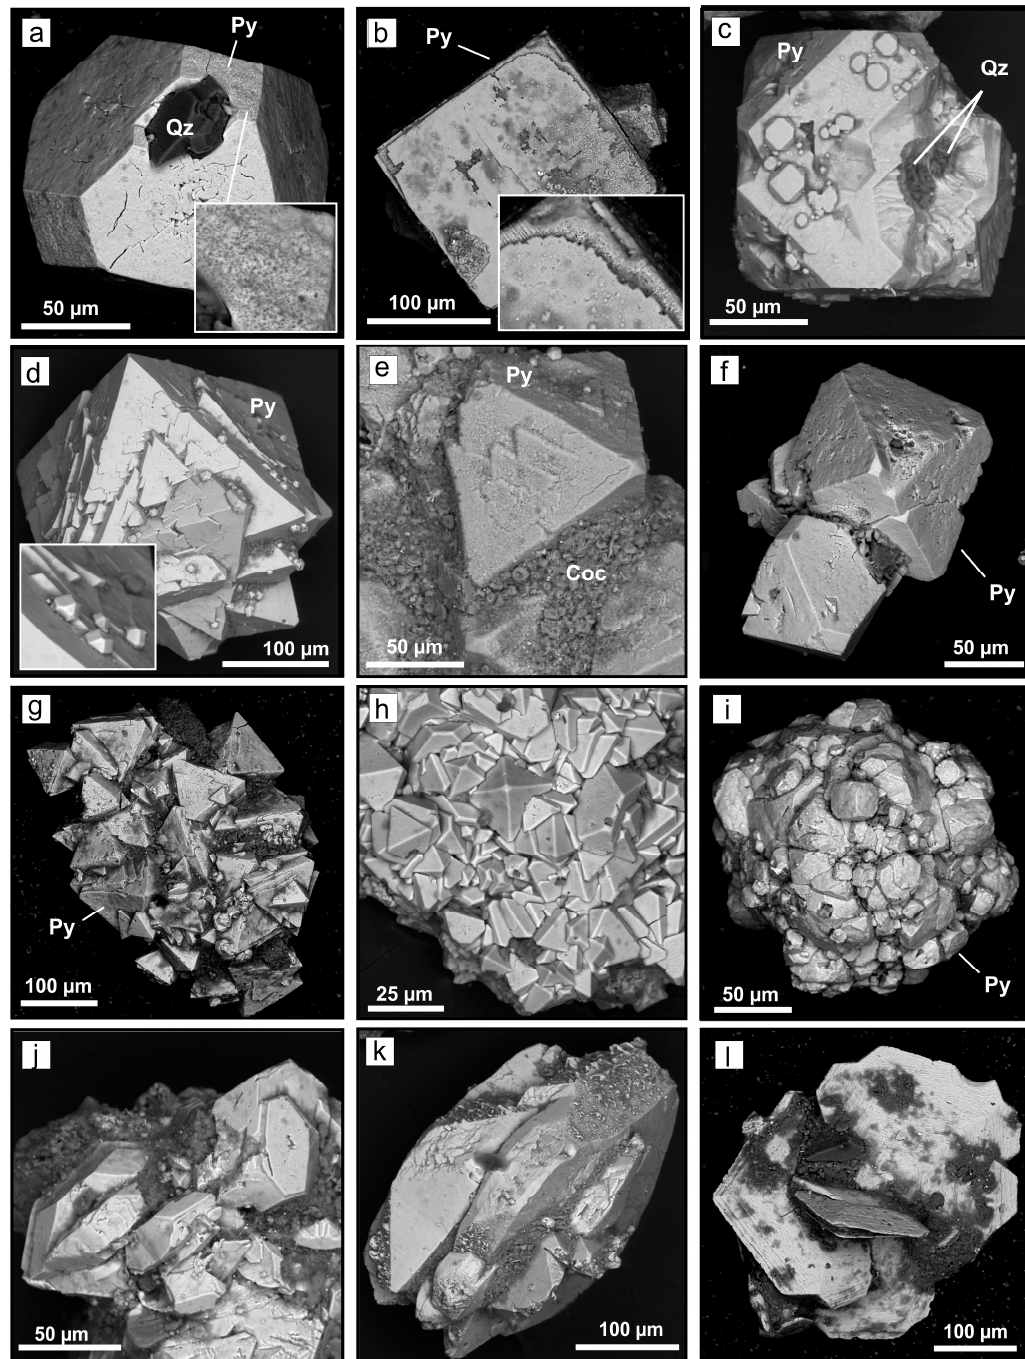
Figure 8. Morphology of large pyrite ( a – i ) and marcasite ( j – l ) crystals from mud masses (Bulganak area). ( a ) Cubo-octahedral pyrite crystal. Some faces are heavily etched; ( b , c ) Cubic ({100}) crystals. Crystal faces are heavily etched ( b ), have stepped growth layers ( c ) and are dusted with microcrystals of later generations ( b , c ). Some crystals show {111} faces ( c ); ( d – h ) Octahedral ({111}) crystals and their aggregates. Some crystal faces are heavily etched ( e – g ), have screw dislocations ( d , g ) and are dusted with microcrystals of later generations ( d ). Pyrite coexists with coccoliths ( e ), clay and quartz ( f , g ); ( i ) Rounded aggregate of cubo-octahedral crystals ({100} faces are dominated). Some octahedral faces are heavily etched; ( j , k ) Tabular (flattened on (010)) and prismatic crystals of marcasite coexisting with clay and quartz; ( l ) Twins of marcasite coexisting with clay and quartz. BSE images. Coc = coccoliths; Py = pyrite; Qz = quartz. ( a , b , i , l ) = Tischenko Hill; ( c – e , h , j , k ) = Trubetskoy Hill; ( f , g ) = Andrusov Hill.